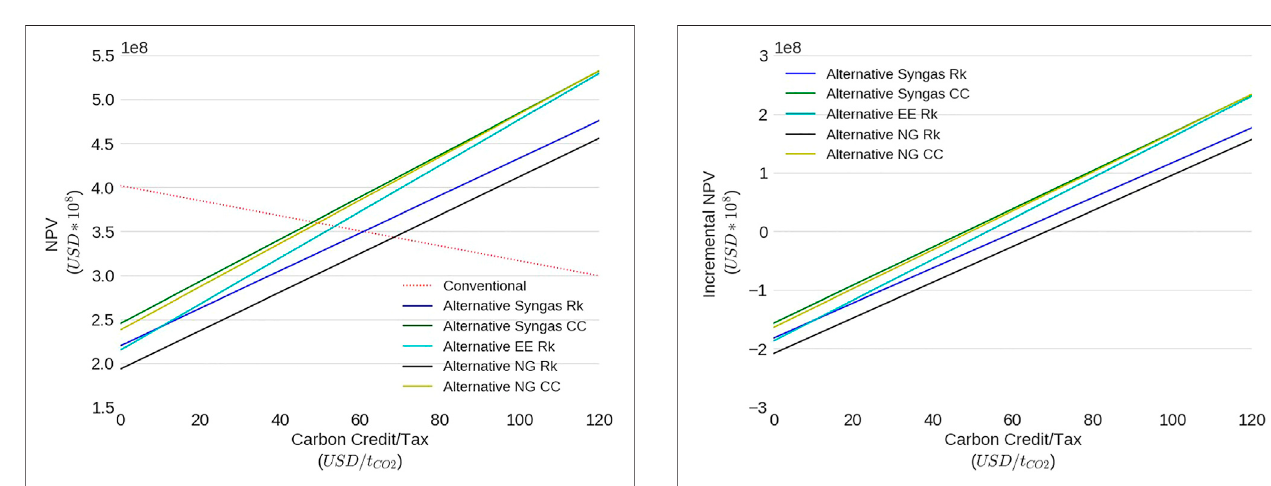
200 days adopted for the sugarcane harvesting season.